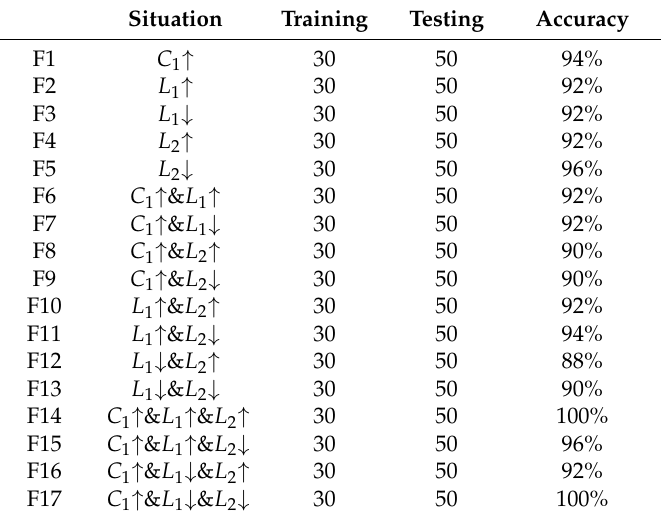
Table 3. Classification